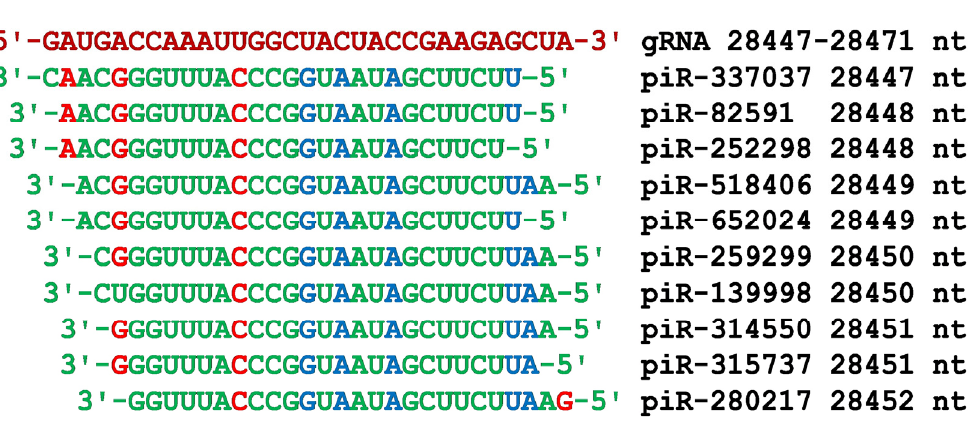
Figure 13. Nucleotide sequences of the 4 piRNA BSs cluster of gRNA from 29,280 nt to 29,308 nt and the nucleotide sequences of piRNAs. Note: The piRNA nucleotides that form canonical pairs with gRNA are highlighted in green and non ‐ canonical pairs are highlighted in blue. The piRNA nucle ‐ otides that do not interact with gRNA are highlighted in red. The names of the piRNAs are followed by the beginning of their BSs. The clusters of piRNA BSs in gRNA that we have identified form the basis for select ‐ ing the most effective piRNAs that can be used to suppress SARS ‐ CoV ‐ 2 proliferation. From the list of piRNAs (Table S1) that interacted with gRNA with a free energy of − 130 kJ/mol or more, we selected 16 piRNAs based on which, by replacing nucleotides, we made the spiRNA nucleotide sequences that interact with gRNA in completely comple ‐ mentary way by forming canonical nucleotide pairs. The interaction patterns of spiRNAs and gRNA BSs are shown in Figure 14. Each of these spiRNAs will reliably block both the synthesis of the protein encoded by the spiRNAs target and gRNA replication. The effec ‐ tiveness of spiRNAs is expected to be the same as in many experiments using synthetic interfering siRNA molecules [51–55].